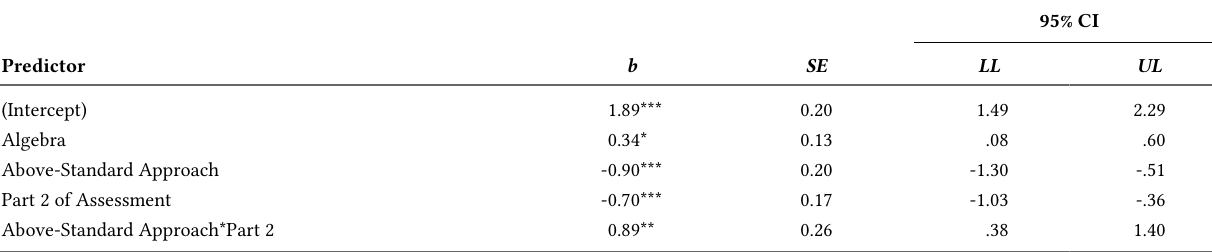
Mixed-Effects Logistic Regression Results Showing Prediction of Accuracy in Log-Odd